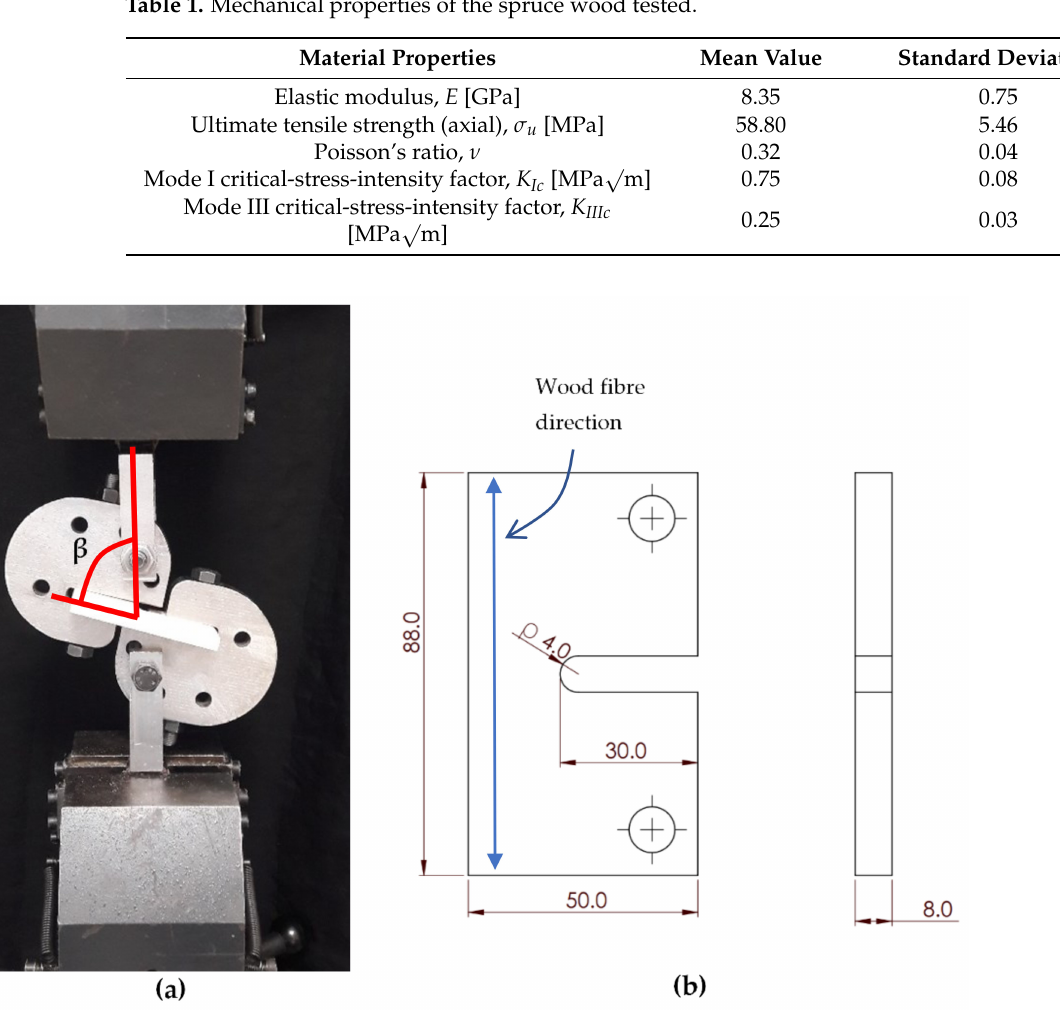
Figure 3. ( a ) Fracture test configuration and β angle definition; ( b ) U-notched test specimen (dimen- sions in mm), with ρ = 4.0